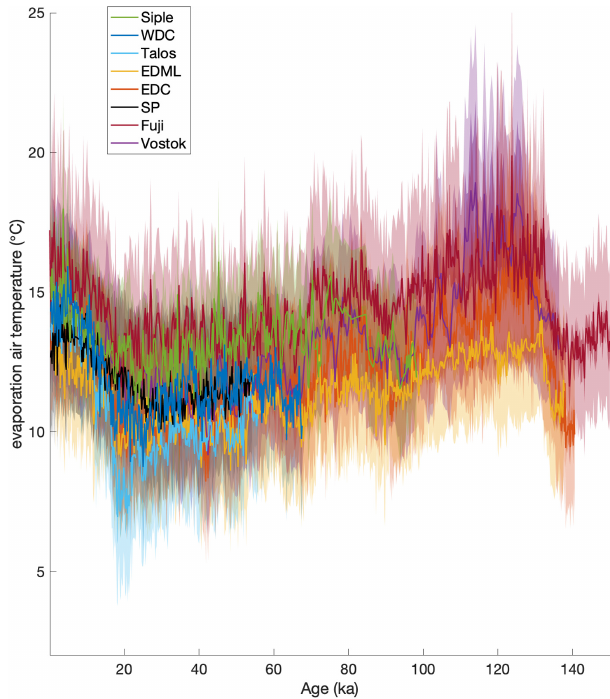
Figure A17. Source region evaporation air temperature reconstruc- tion for all ice-core sites. The light shading around the reconstruc- tions represents the uncertainty in absolute temperature, while the darker shading represents the uncertainty in relative temperature variability as described in Sect.